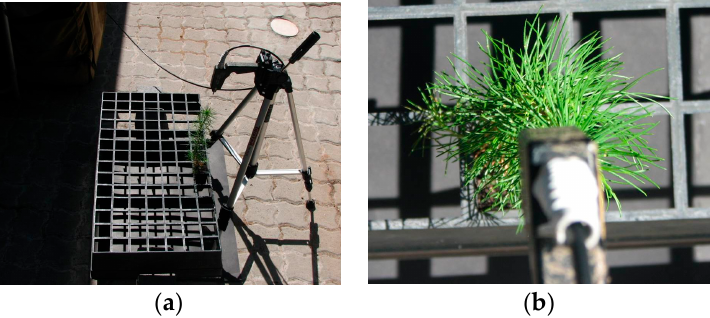
Figure 1. Experimental setup of the spectroradiometer used for spectral data collection ( a ) showing the orientation (nadir view) of the pistol relative to the seedling ( b ).